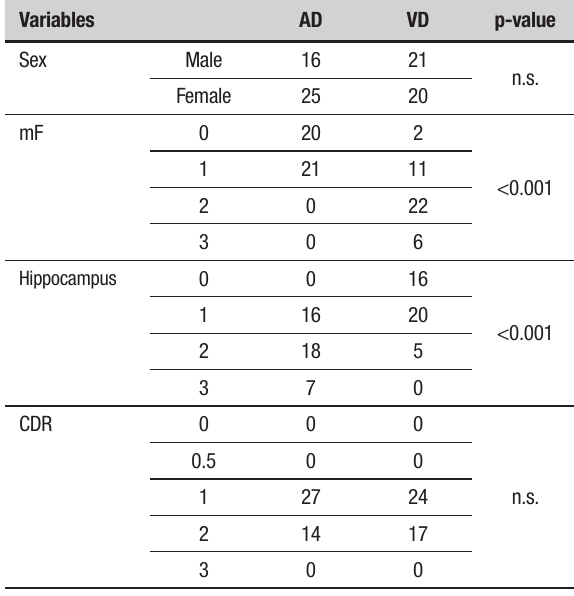
Table 2. Distribution of categorical variables between the diagnostic